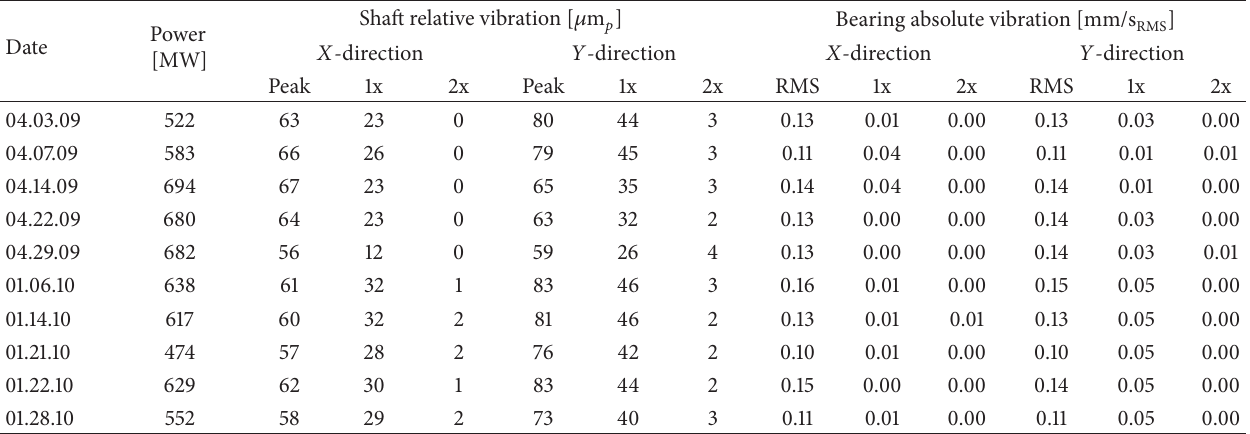
Table 2: Typical shaft relative and bearing absolute vibrations in the upper journal bearing of a